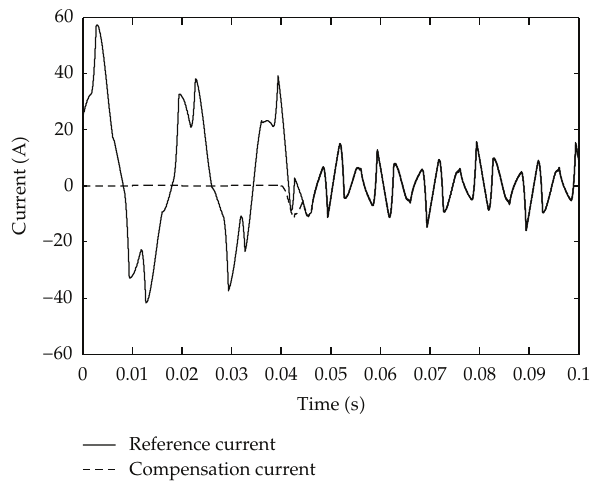
Figure 6: Instructions current and compensation current.